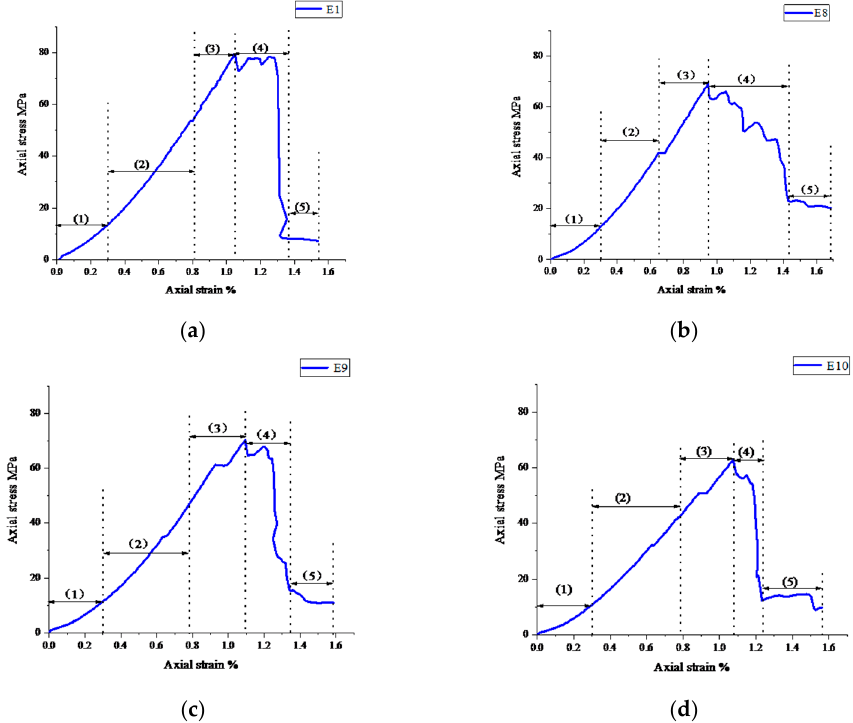
Figure 3. Stress–strain curve. ( a ) Test piece E1, ( b ) test piece E8, ( c ) test piece E9, ( d ) test piece E10.